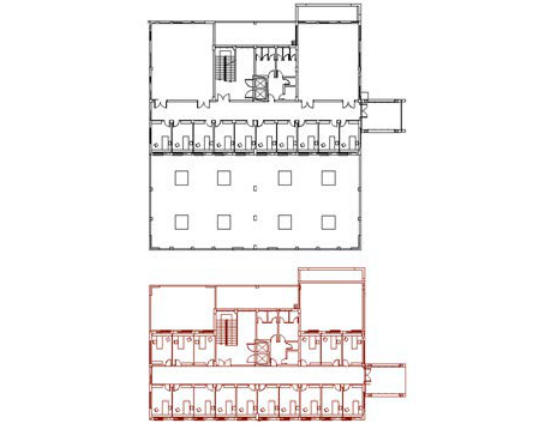
Figure 1. Architectural plans of a part of Lampadarios Building An example of a rule file (containing all the rules for the creation of a building’s geometry) can be seen below.